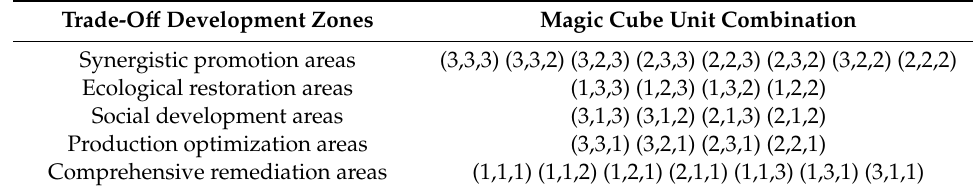
Table 3. Criteria of SEPLs’ trade-off development zones.